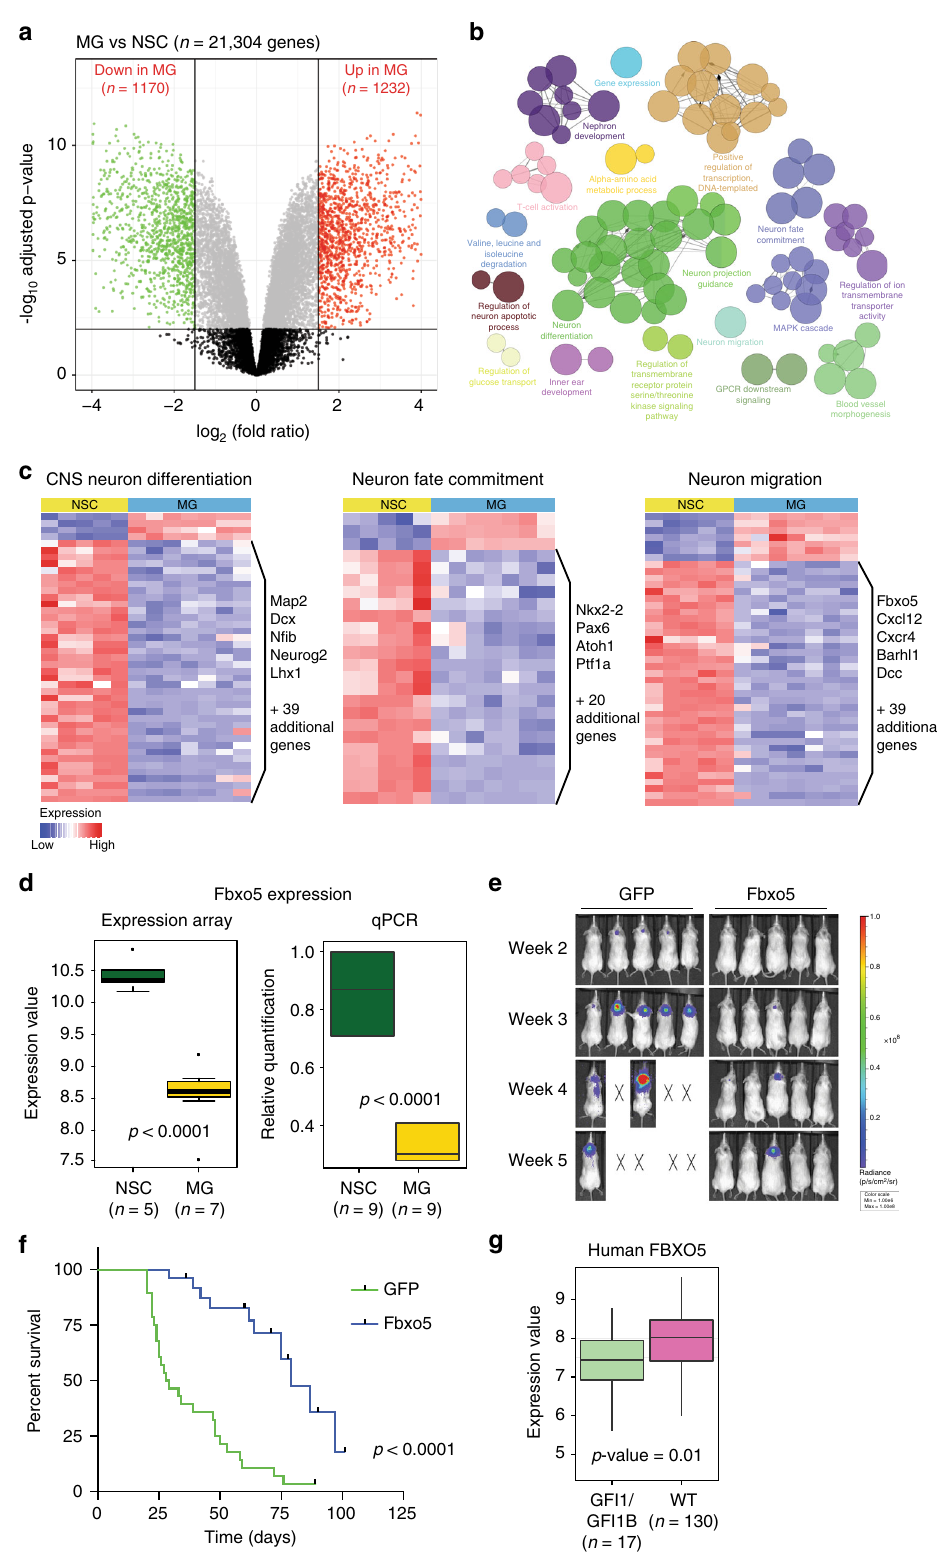
tary Fig. 11a, b). When tumors reached 2 cm in diameter, the experiment was terminated, and tumors were collected and weighed (Supplementary Fig. 11c, d). As shown in Supplementary Fig. 11a-d, treatment with GSK-LSD1 signi fi cantly slowed tumor growth and decreased the size of MG tumors in vivo. We